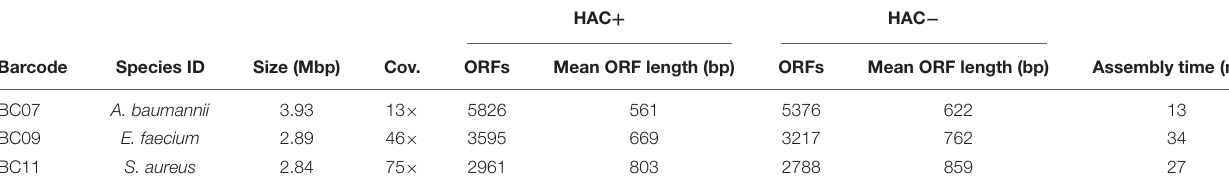
TABLE 4 | Assembly statistics for clinical isolates of pathogenic bacteria characterized in this